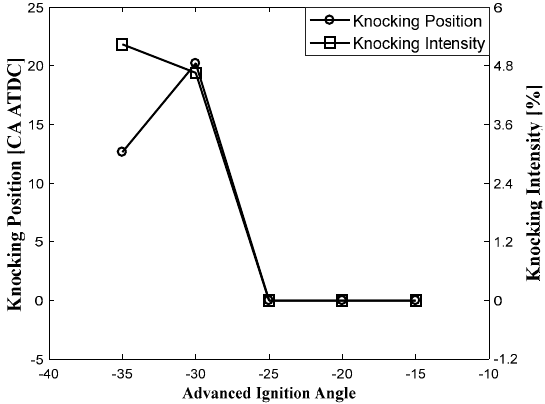
Figure 26. Knocking position and knocking intensity with different advanced ignition angles.